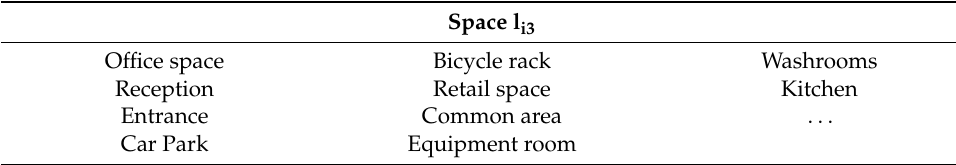
Table 4. Asset Omni-management